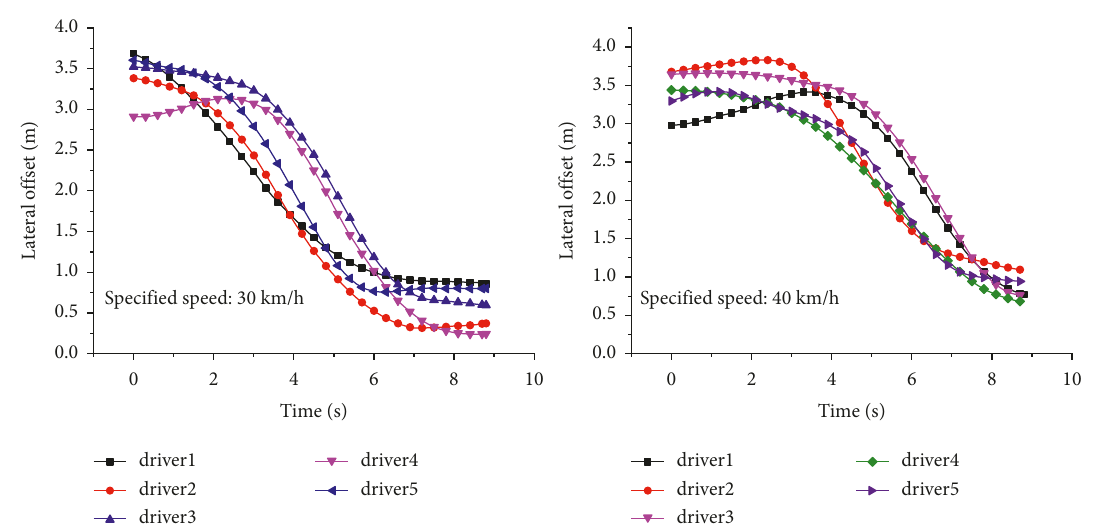
Figure 5: Lateral offsets of five skilled